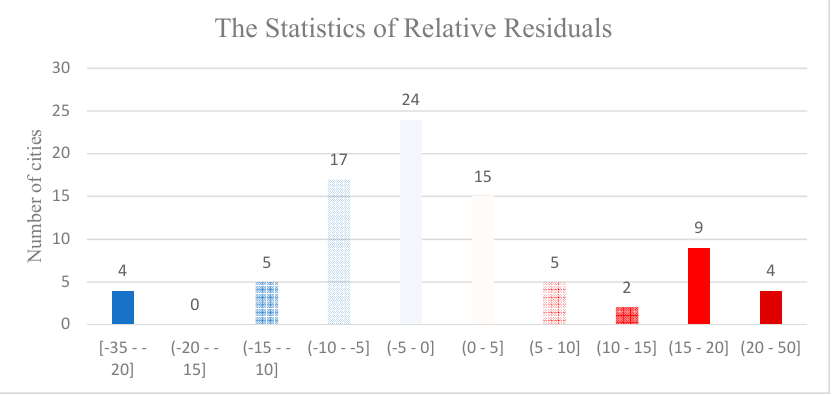
Figure 8. The statistical result of the relative residuals by using the OSM road network density.